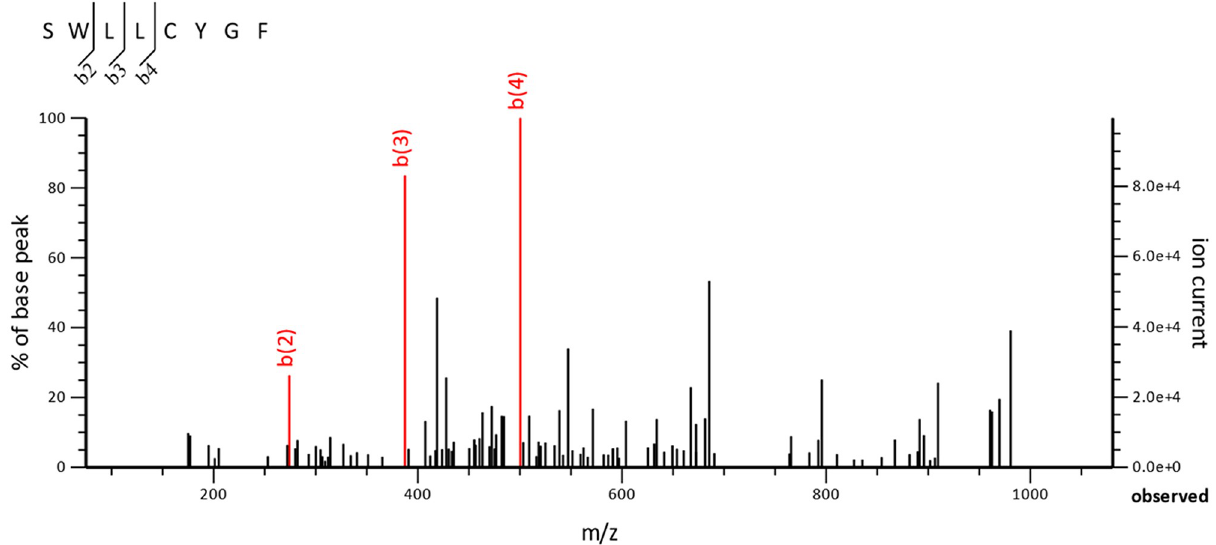
Fig 4. Verification of ubiquitin sequence by liquid chromatography–tandem mass spectrometry (LC–MS/MS). MS/MS fragmentation of SWLLCYGF found in free ubiquitin D (fUBD) is shown.